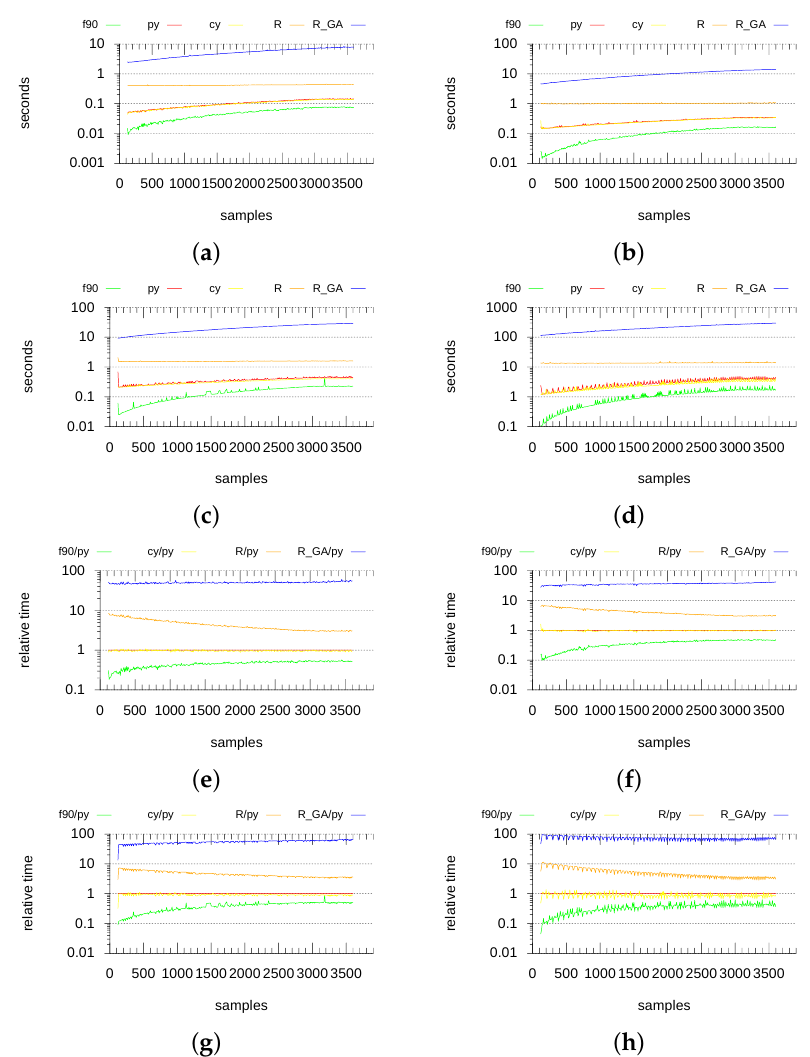
Figure 6. Execution and relative times of the five code version in the four computing